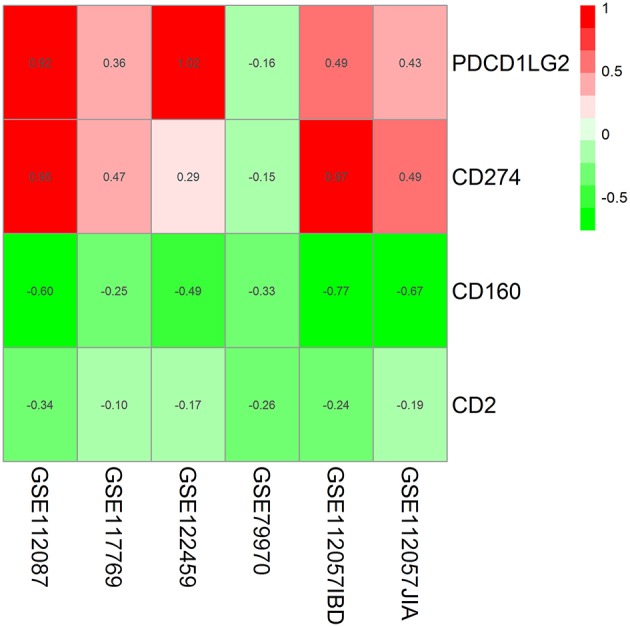
Heatmap shows those significant genes in the RRA analysis of 6 RNA-seq datasets. Data from 6 RNA-seq datasets were integrated using RRA method. CD160 was the most significant down-regulated gene in autoimmune diseases (Adjusted P = 5.9E-09), while CD58 was not an obviously significant gene in the RRA validation study. The numbers in the heatmap were for the logarithmic fold change in each dataset which was calculated by the limma package. Red indicated increased expression, and green indicated decreased expression.